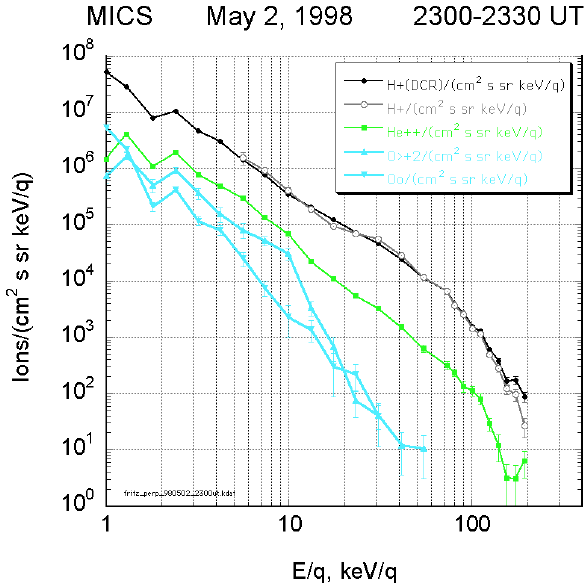
Fig. 8. The energy spectrum of flux versus energy/charge of the four major ion species determined for the interval from 23:00UT to 23:30UT on 2 May